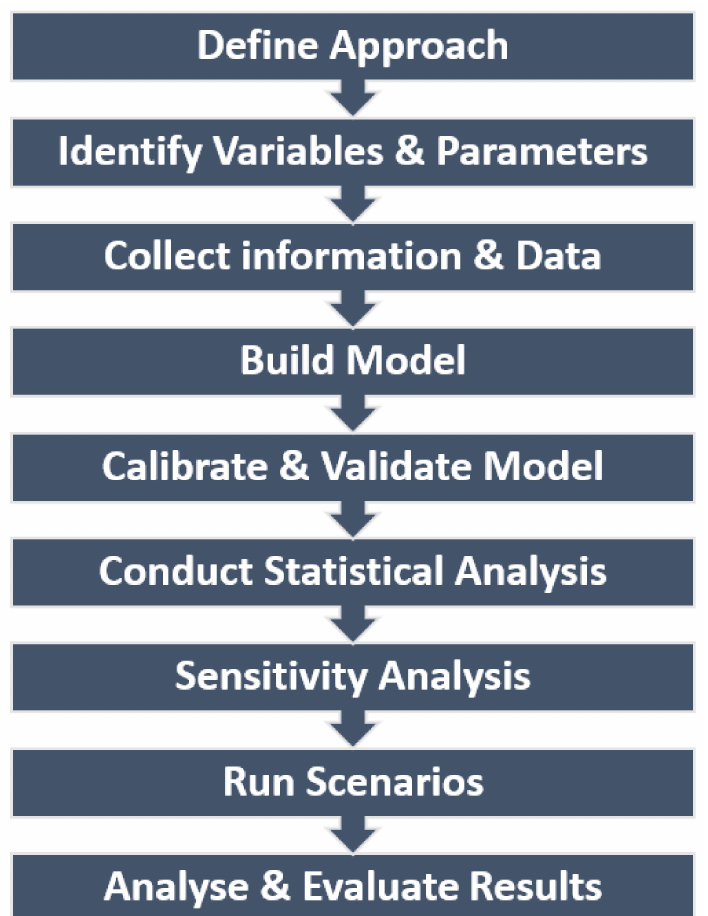
Figure 2. Overview of systematic steps followed as part of the modelling